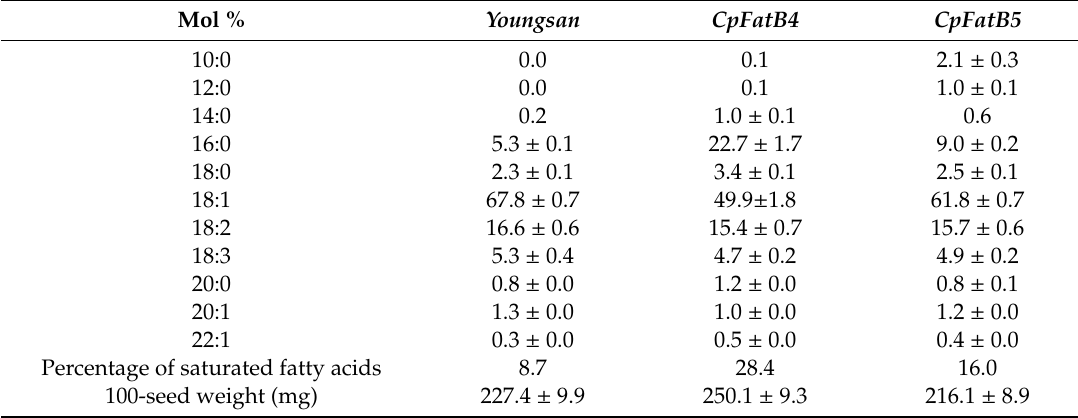
Table 1. Seed fatty acid profiles (mol %) and 100-seed weights showed di ff erent patterns depending on the transgene expressed. Youngsan (non-transgenic control plant, n = 12), CpFatB4 ( n = 10), and CpFatB5 ( n = 10). Seeds for each transgenic line were collected from T4 plants originating from the same T3 parent. Values are indicated as mean ± standard